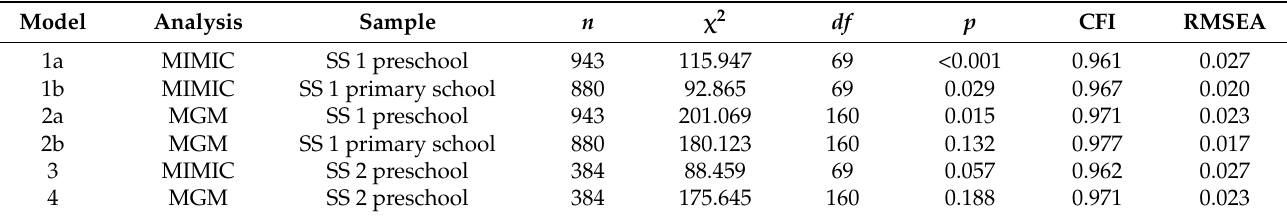
Table 3. Data fit of the calculated